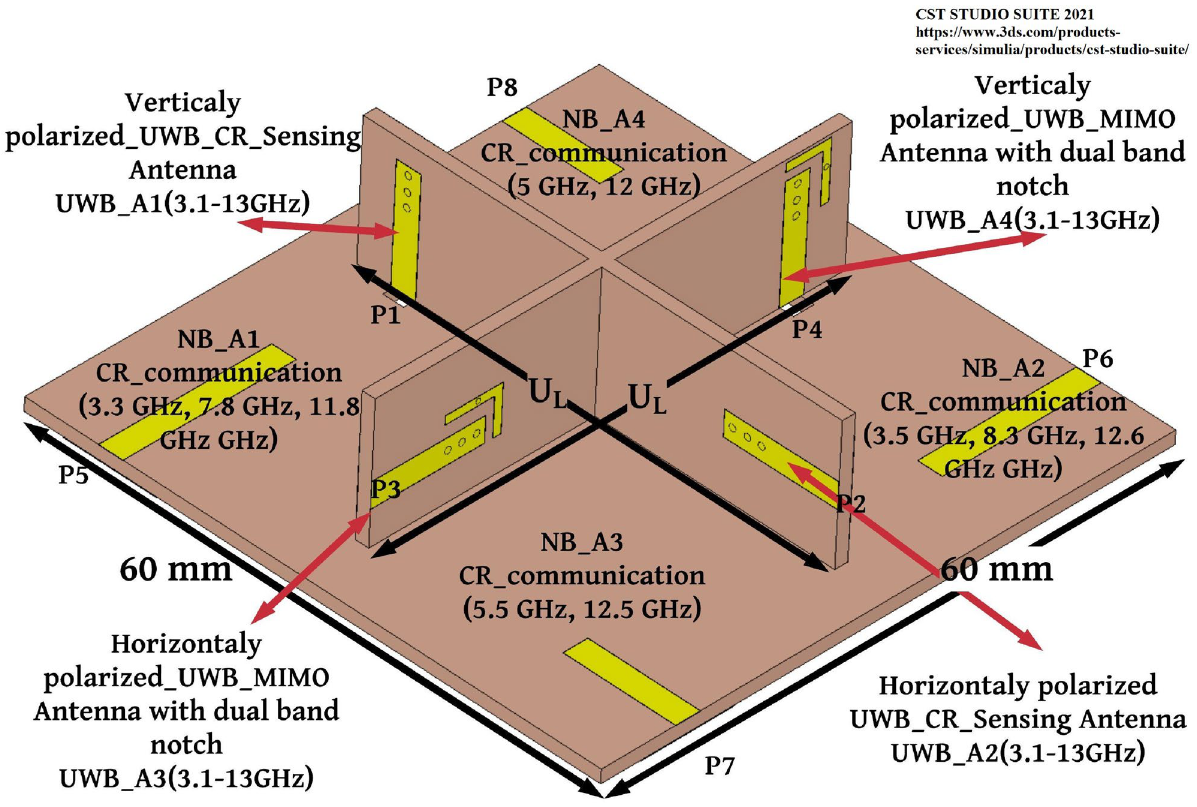
Figure 10. Integrated antenna system. (CST STUDIO SUITE